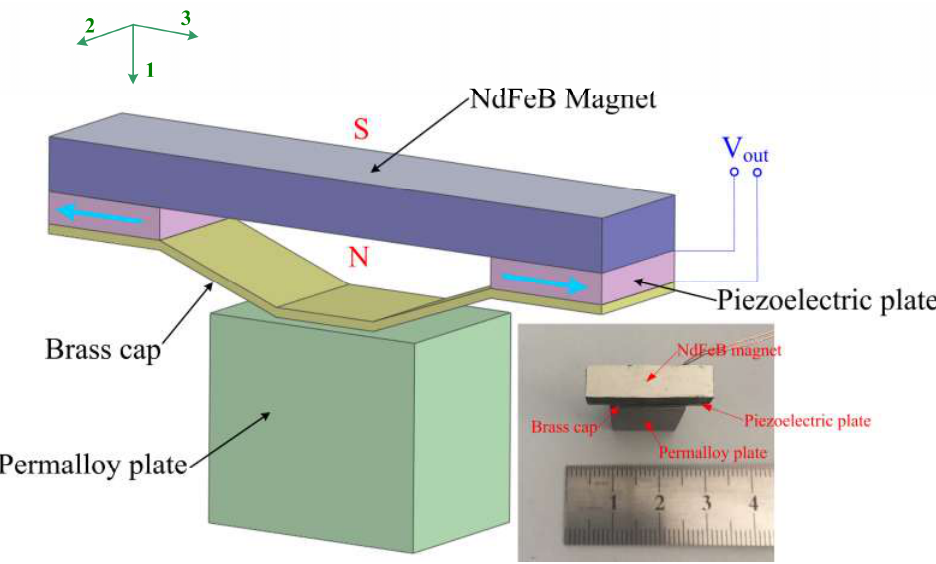
Figure 1. Schematic diagram and photograph of the proposed piezoelectric heterostructure.